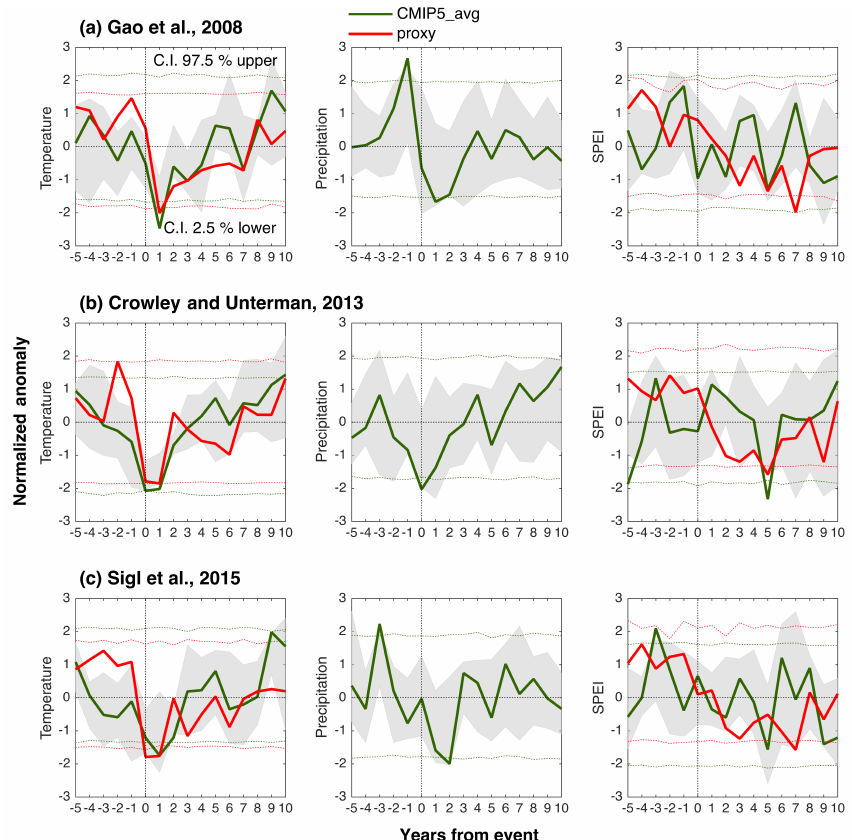
Figure 4. Modeled and reconstructed hydroclimate response to eruptions. Superposed epoch analysis using the 20 largest eruption years from (a) Gao et al. (2008), (b) Crowley and Unterman (2013), and (c) Sigl et al. (2015). Table 3 lists the event years used in the analysis. Grey shading indicates the range of modeled hydroclimate response from the six GCMs. Confidence intervals (C.I.) are derived from bootstrap resampling ( N =